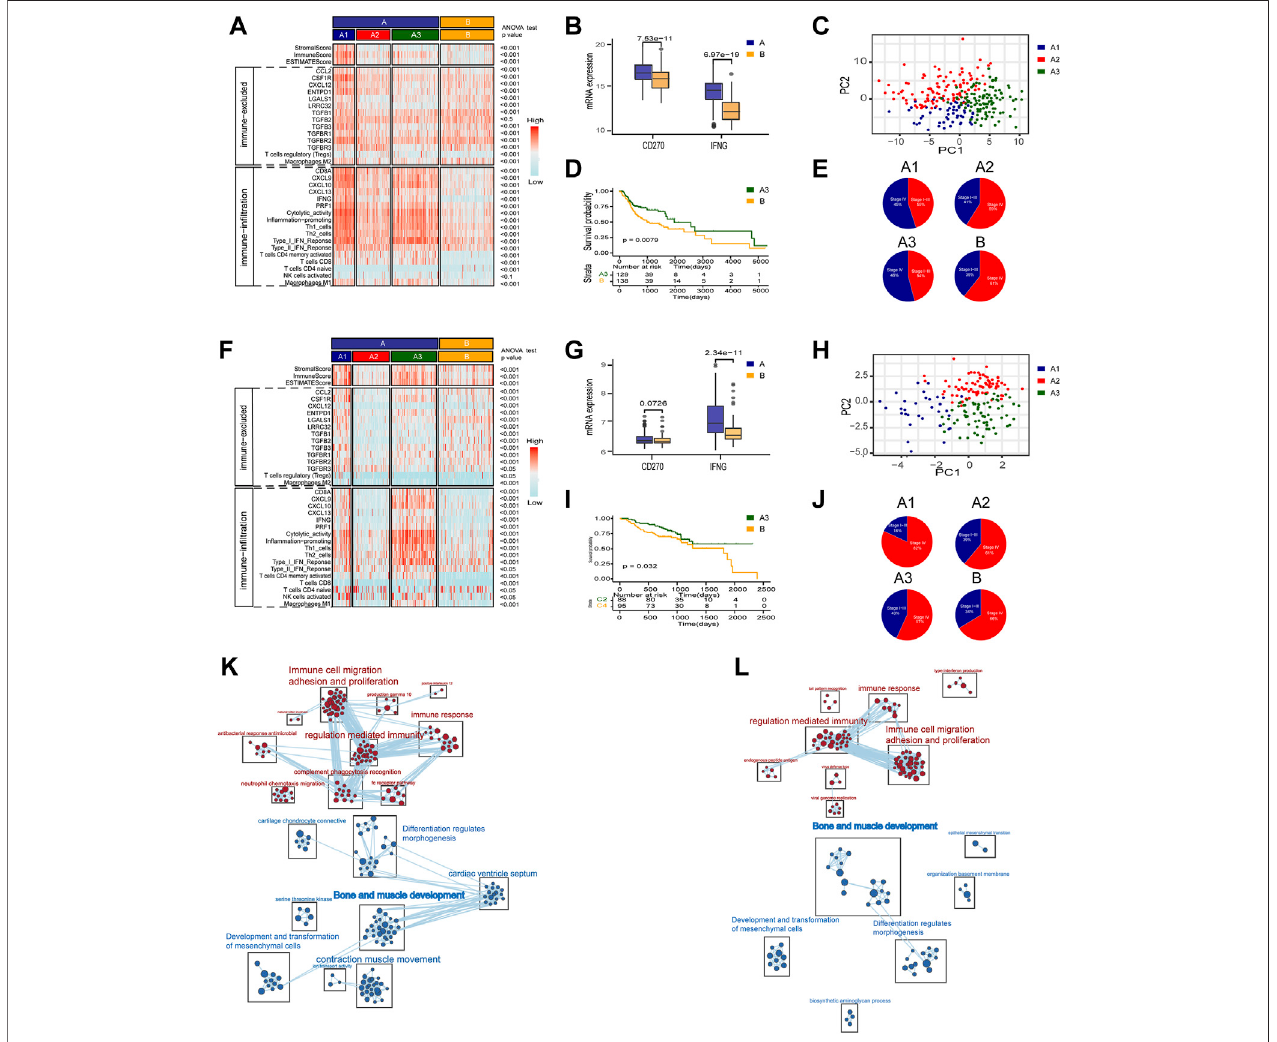
FIGURE3| Atwo-stepmolecularclassi fi cationcombiningtheearlydifferentiationfeaturesofTAMMand22immunecellscores. (A,F) Heatmapsofimmune-related components, stromal score, and tumor purity score of the HNSCC subtypes in TCGA HNSCC (A) and GSE65858 cohorts (F) . (B,G) IFNG, PD-L1 expression level of subtypeofTCGAHNSCC (B) andGSE65858 (G) . (C,H) PCAofthemRNAexpressionof54earlydifferentiationfeaturegenesfromtheHNSCCpatientsintheTCGA (C) and GSE65858 cohorts (H) . (D,I) Kaplan-Meier curves for overall survival (OS) of all HNSCC patients in TCGA (D) and GSE65858 (I) within A3 and B subtypes. (E,J) ThepiechartshowedtheproportionofTMNstageswithfourdifferentimmunophenotypesinTCGA (E) andGSE65858cohorts (J) . (K,L) GSEAnetworkofDEGsin A3 vs B subtypes using Enrichment map in TCGA (K) and GSE65858 cohorts (L) .